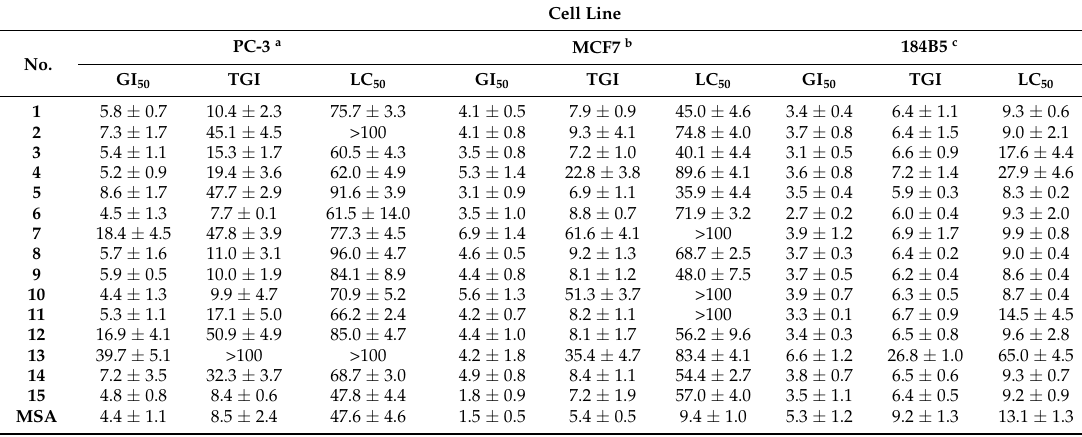
Table 4. Cytotoxic activity of the novel methylselenoesters at 72 h. Average GI 50 , TGI and LC 50 ± SD values are expressed in μ M.